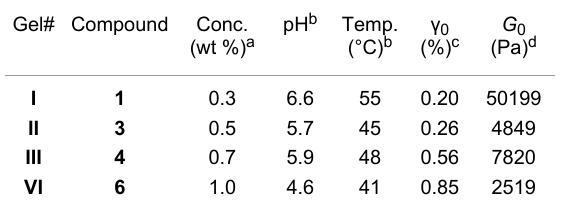
Table 1: Typical conditions for the hydrogelation of the phenylalanine